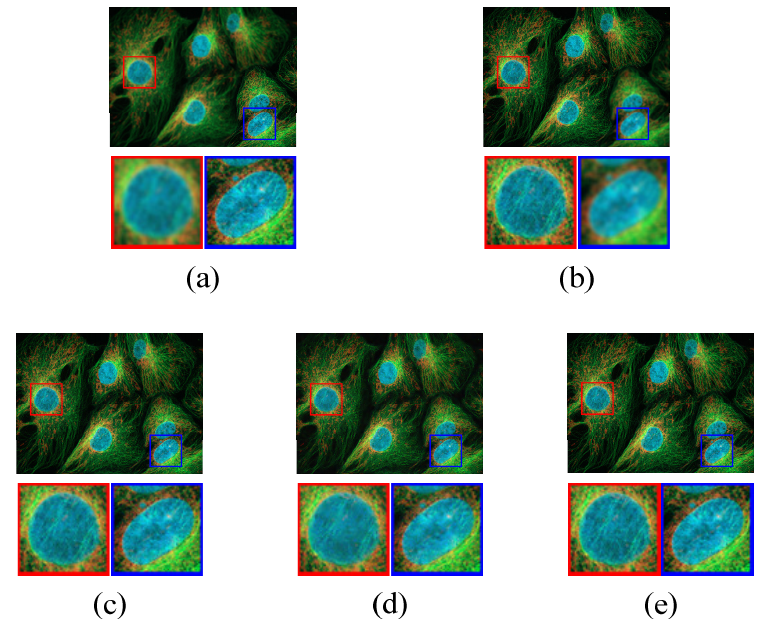
Figure 8. Fusion Results of Multi-focus Fluorescence Image - 3, ( a , b ) are source images, ( c – e ) are fused image of KSVD, JPDL, and proposed method respectively.